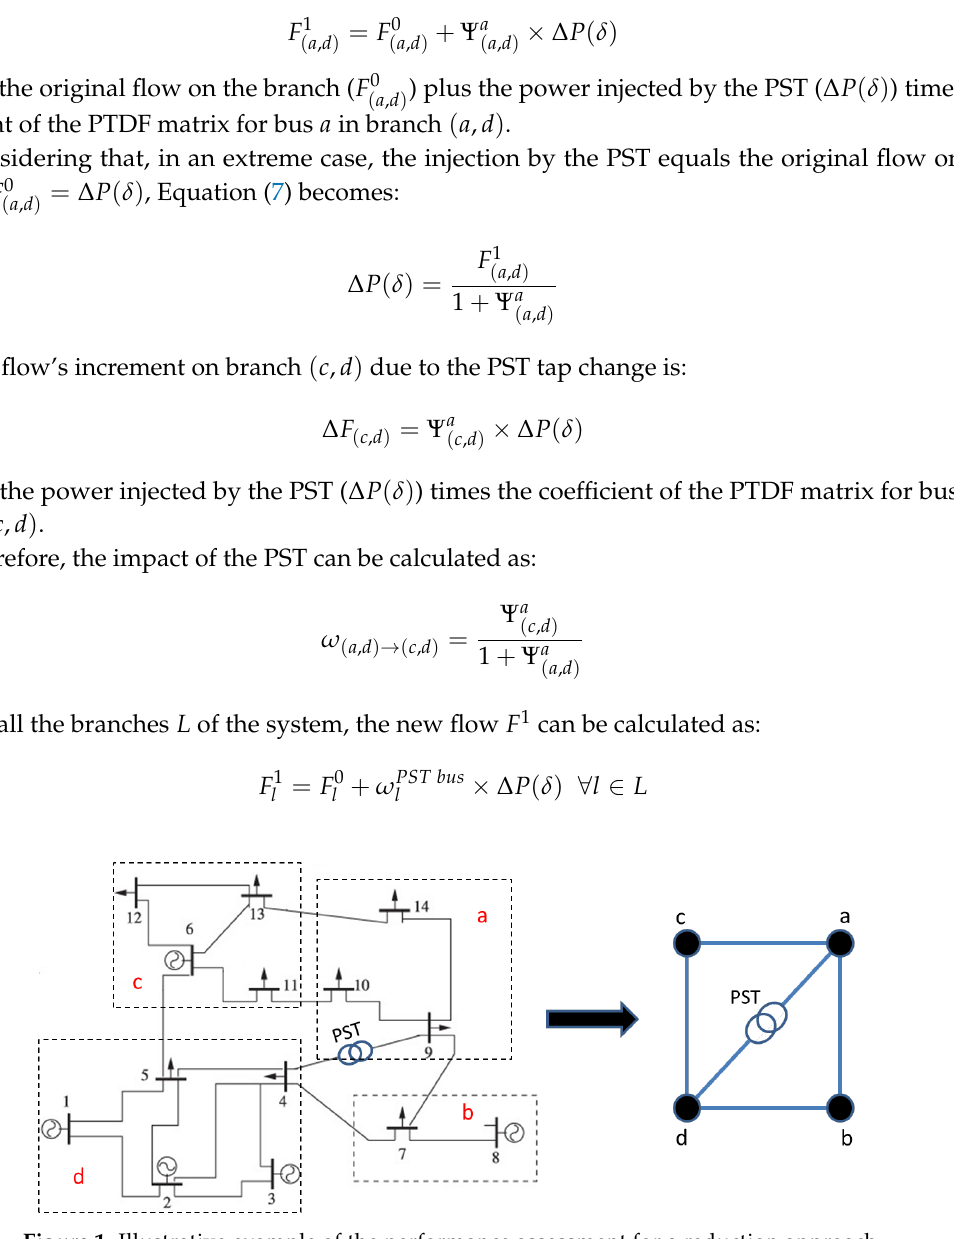
Figure 1. Illustrative example of the performance assessment for a reduction